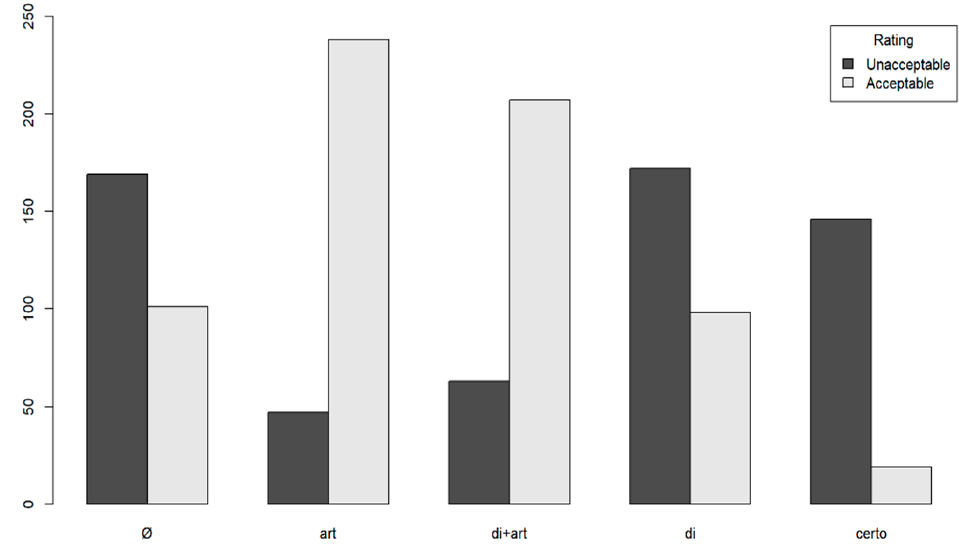
Figure 2. Bar plot of the overall (un)acceptability rate for the indefinite determiners.